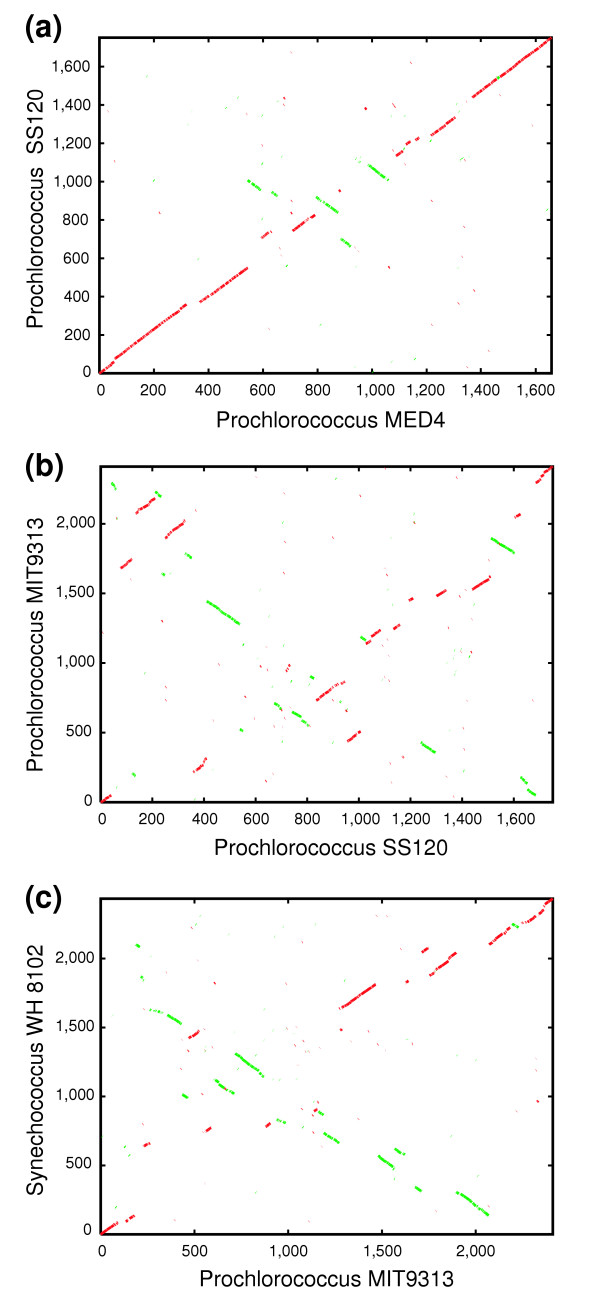
Alignments of complete genome sequences of marine picocyanobacteria. Genome sequences are translated in their six reading frames. (a) Comparison of the MED4 and SS120 genomes; (b) comparison of the SS120 and MIT9313 genomes; (c) comparison of the MIT9313 and WH8102 genomes. Colinear segments are shown in red and inversions in green. Translocated segments are above or below the diagonal.